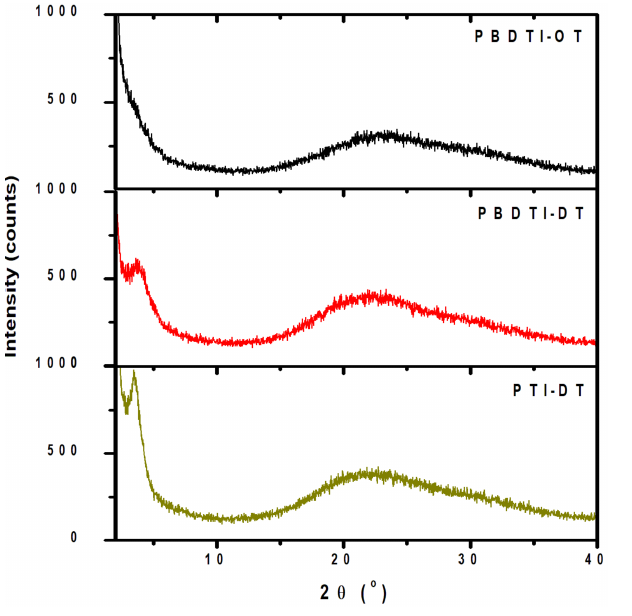
Figure 6. XRD traces PBDTI-OT (black), PBDTI-DT (red) and PTI-DT (dark yellow) in drop-casted